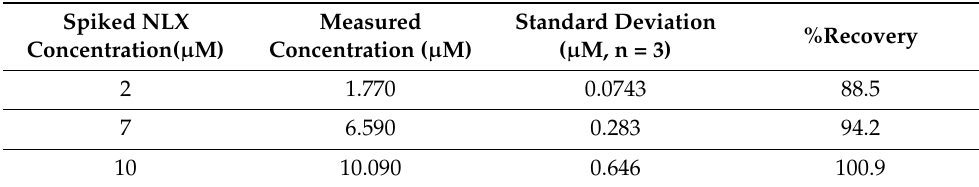
Table 1. NLX concentration determination in spiked urine